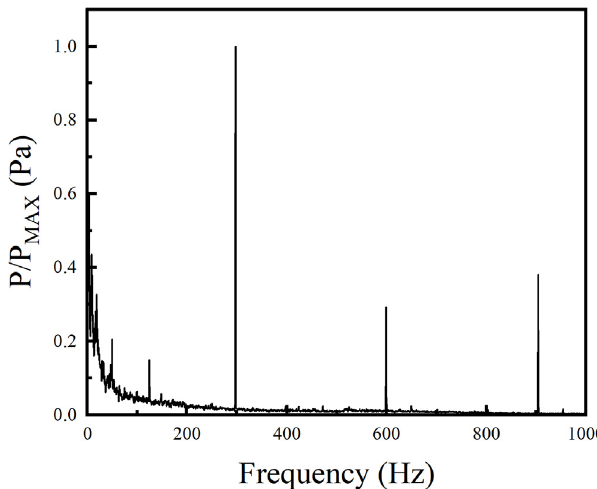
Fig. 20. Spectrogram of pressure pulsation (centrifugal pump speed is about 2955 r/min, fl ow rate is about 110 m 3